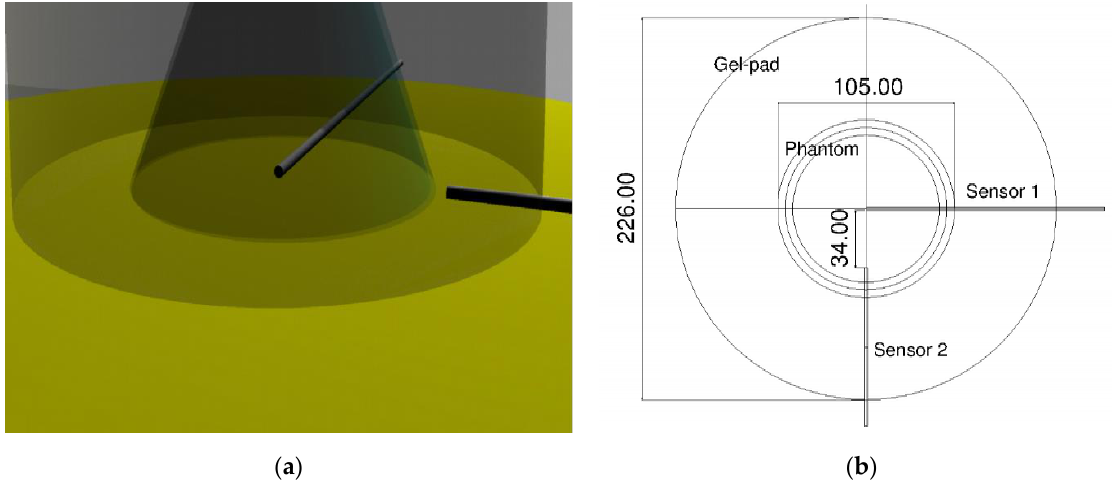
Figure 3. Probe positions relative to the ultrasound field. ( a ) 3D model with the two probes positioned; ( b ) schematics of the positioning/coupling apparatus.